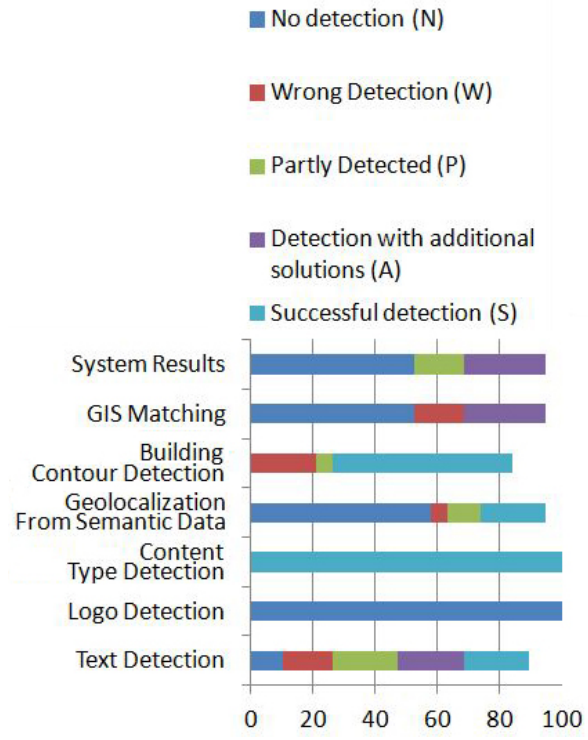
Figure 12. Detection results over our 19 test images.